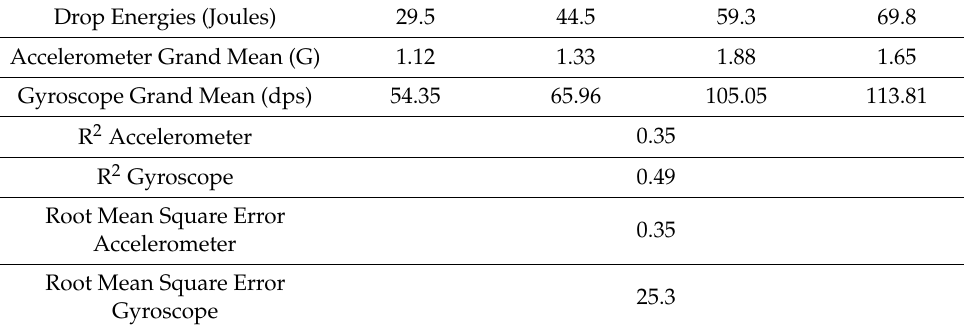
Table 3. Results Robustness